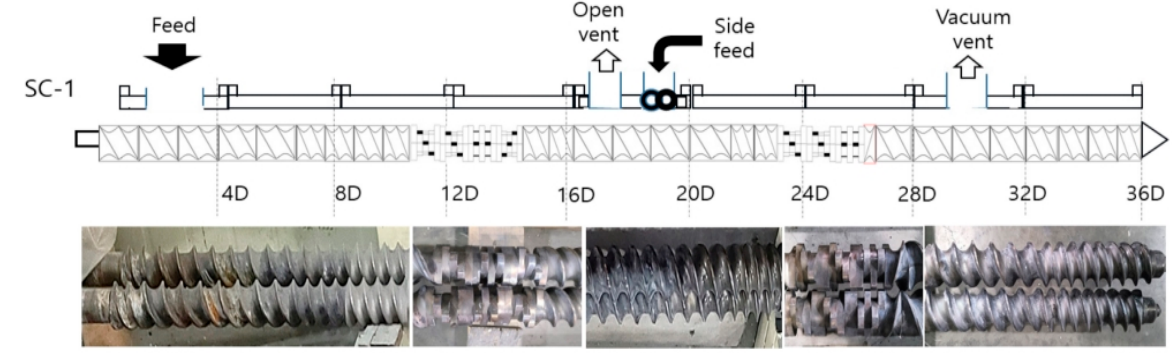
Figure 9. A general screw configuration of an intermeshing co-rotating twin-screw extruder for compounding polymeric materials.